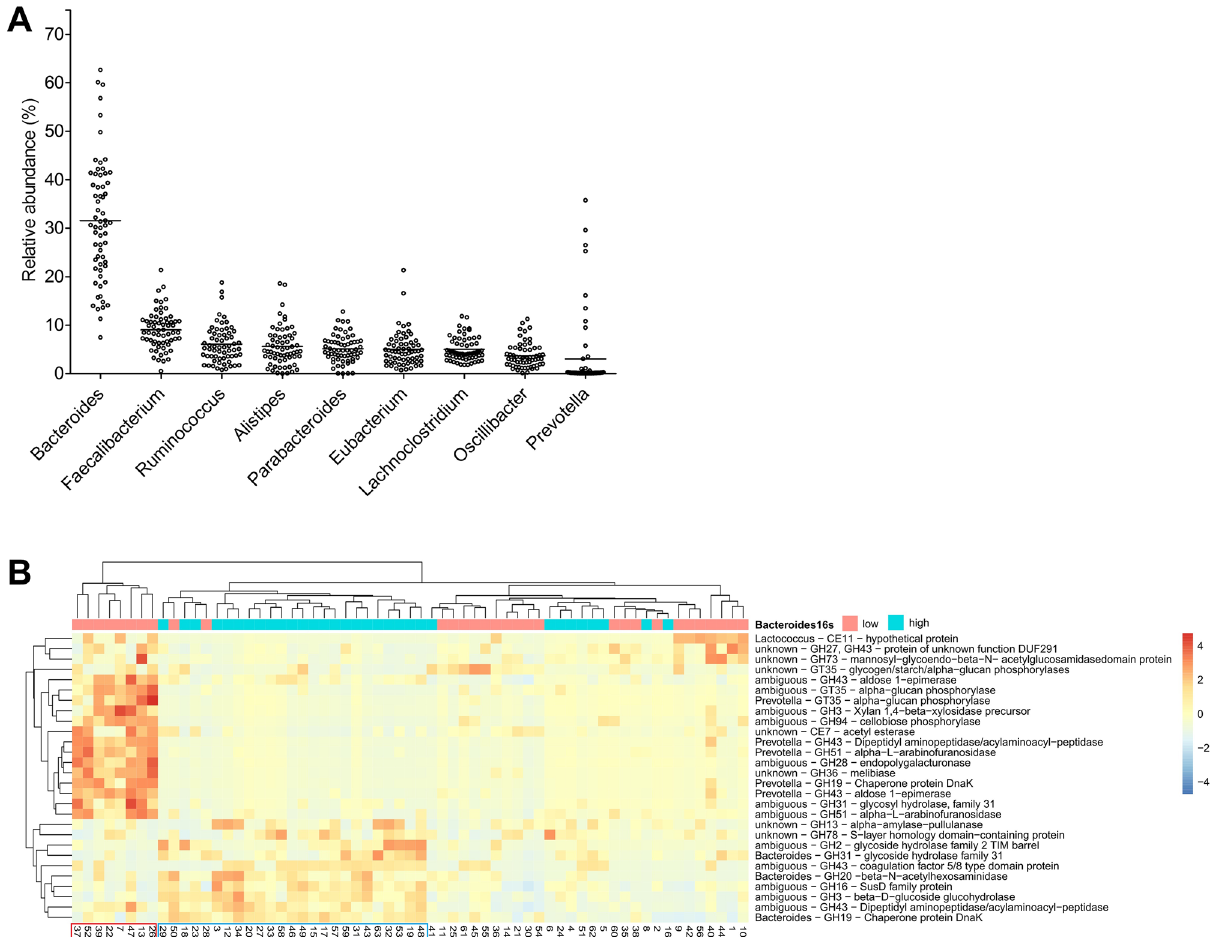
Figure 3. Donors with high abundancy of Bacteroides and donors with high abundance of Prevotella differ in their expression of CAZy. ( A ) Relative abundance of the most prominent bacterial groups on genus-level according to 16S-RNA parallel sequencing. ( B ) A heatmap of CAZy enzymes identifies two distinct profiles of CAZy enzyme expression among donors (in vertical columns). CAZy enzymes (horizontal lines) annotated as Bacteroides - or Prevotella -derived (or ambiguous) are expressed at a higher level in two distinct groups of donors (consisting of 25 and 8 donors, demarcated with blue or red frames, respectively). In ( A ), each dot represents the value of abundance for one donor. Enzymes with a FDR < 0.01 are included in the heatmap